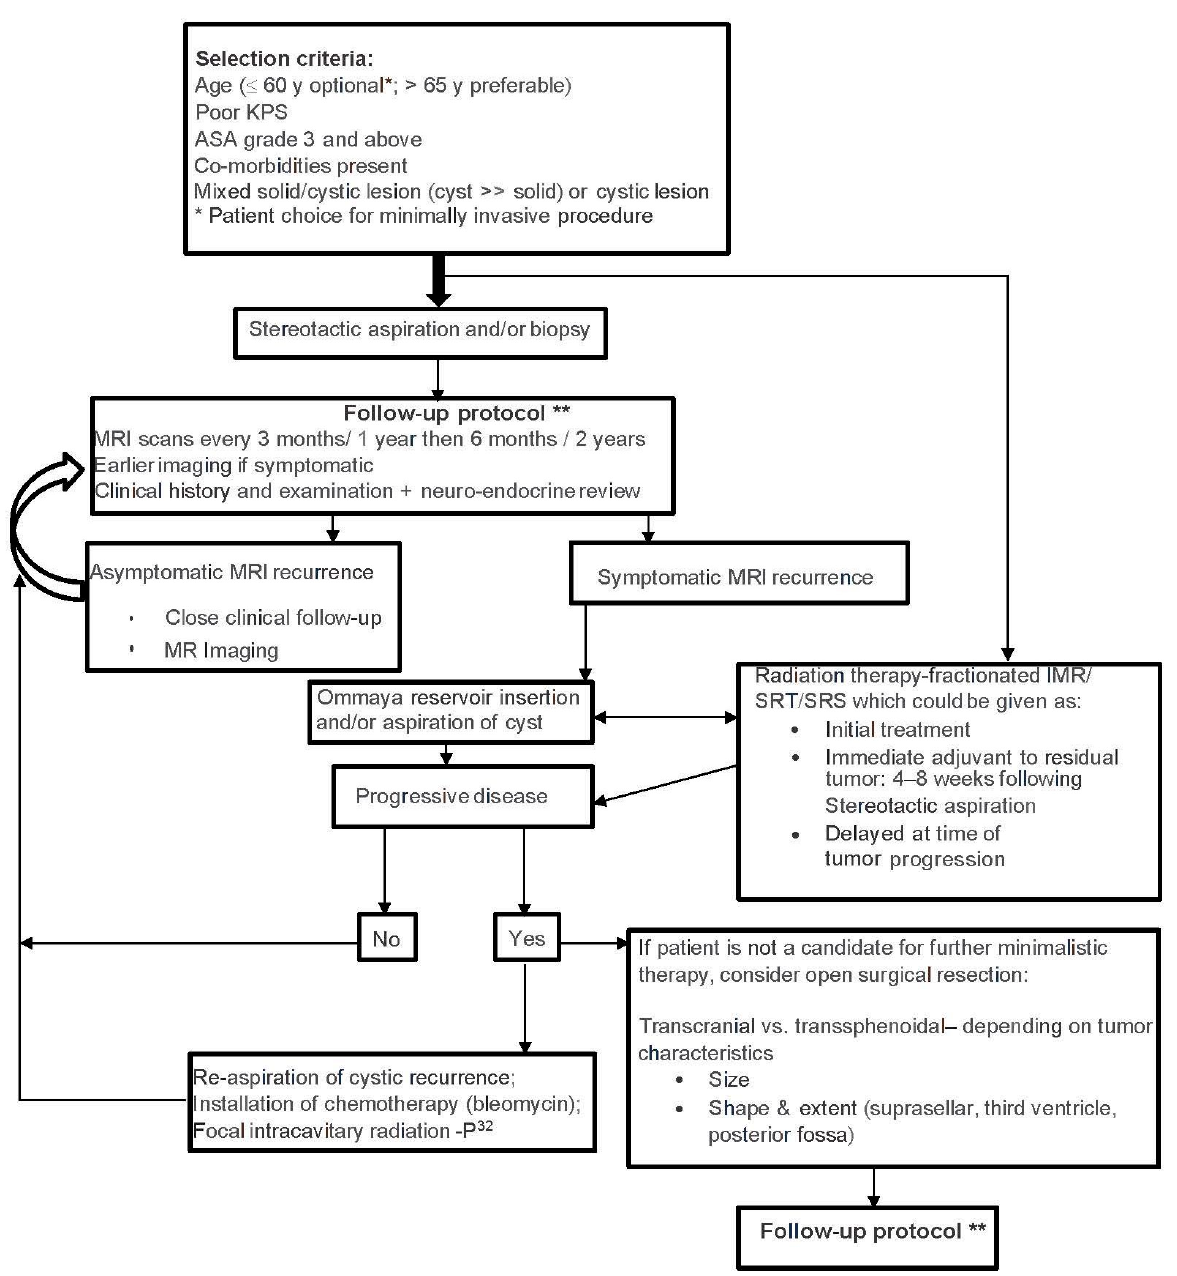
Figure 5. Algorithm by Gazanfar and Gene for the treatment of CPs with minimally invasive techniques combined with radiation. Taken without modifications from [58]. Abbreviations: KPS, Karnofsky Performance Status Scale; ASA, American Society of Anesthesiologists; MRI, magnetic resonance imaging; IMR, intensity modulated radiation; SRT, stereotactic radiation therapy; SRS, stereotactic radiosurgery. (published under Creative Commons Attribution License, which permits unrestricted use, distribution, and reproduction in any medium, provided the original author and source are credited). * Patient choice for minimally invasive produce. ** MRI scans every 3 months/1 year then 6 months/2 years, earlier imaging if symptomatic, clinical history, and examination + neuro-endocrine